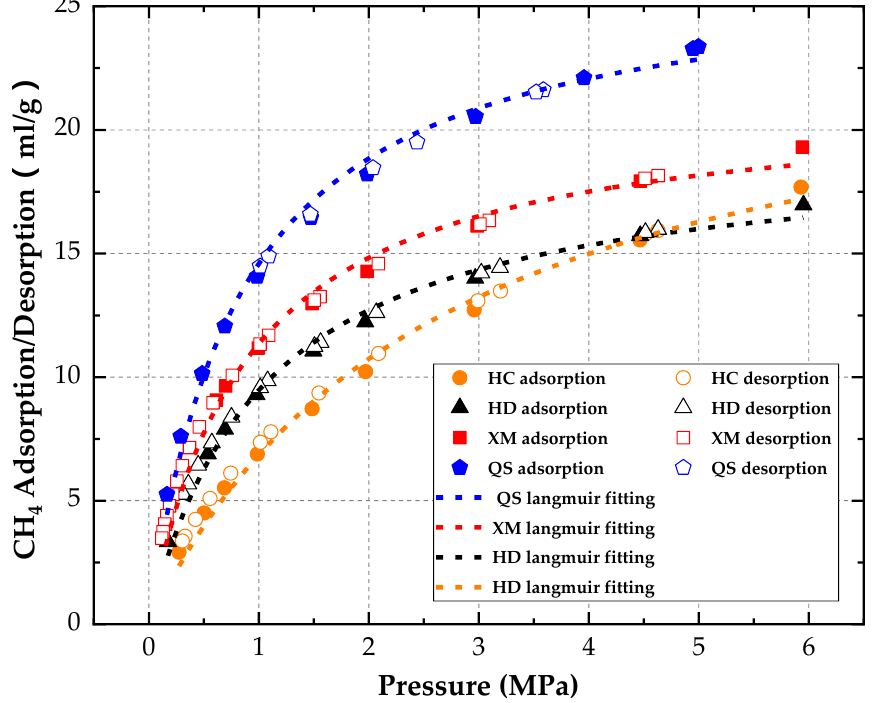
Figure 4. Adsorption-desorption isotherm of coal samples.